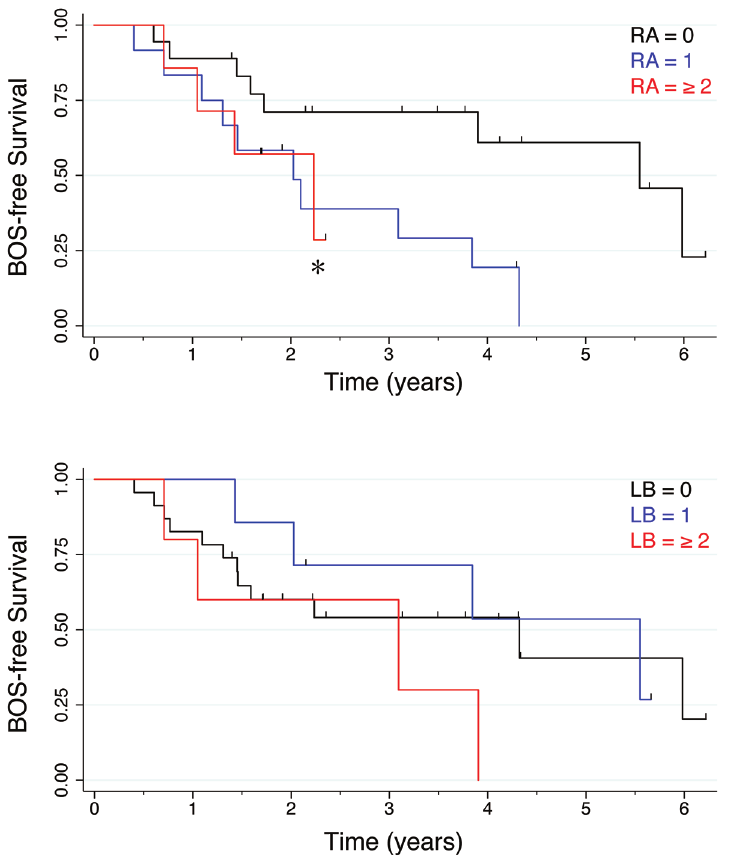
Figure 2. Kaplan-Meier analysis of BOS-free survival in 38 subjects based categorized by grade A rejection status (RA, top panel) or by grade of lymphocytic bronchiolitis (LB, bottom panel). *, P=0.03 for RA by Mantel-Cox log rank test.